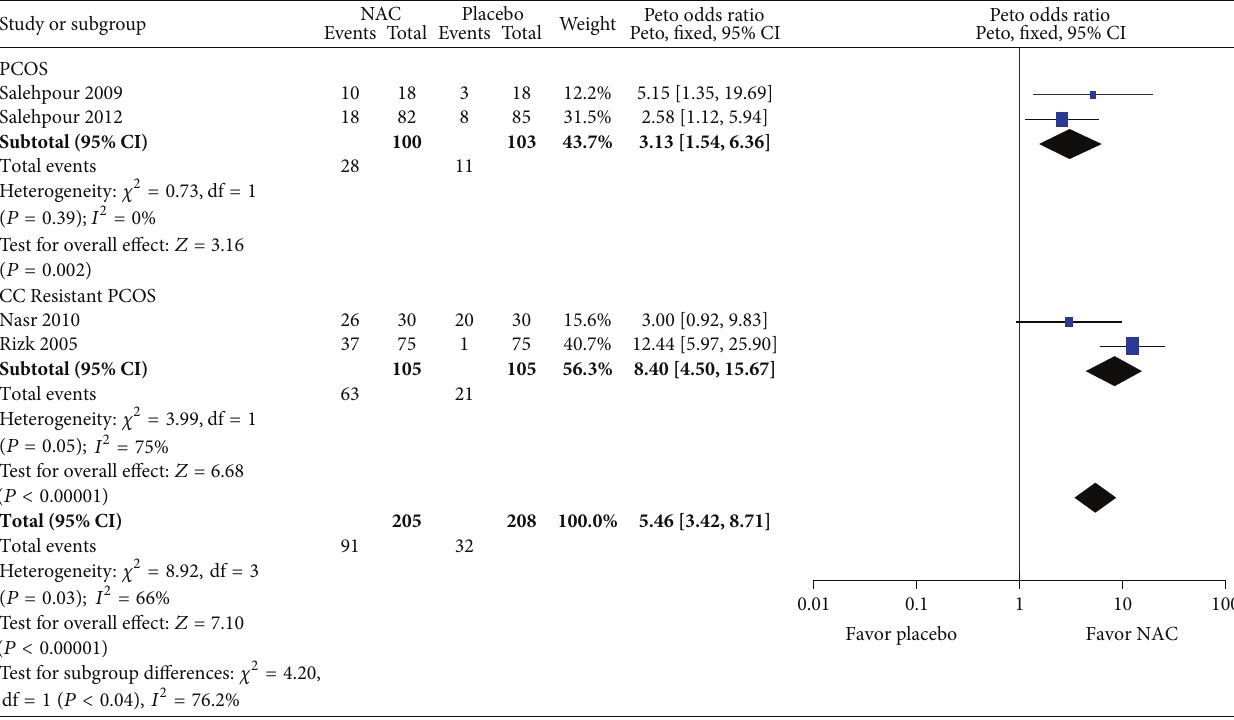
Figure 6: Forest plot: outcome: ovulation rate in women with PCOS comparing NAC with placebo.